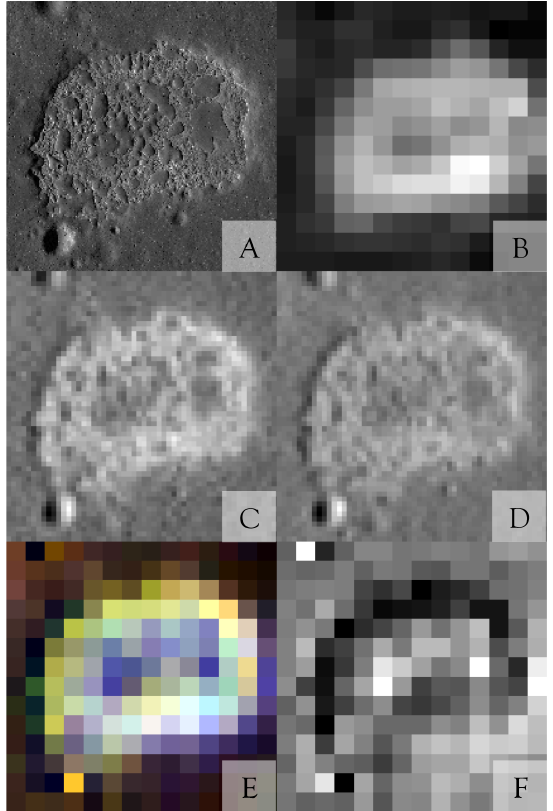
Figure 1: Ina-D - A) Pan - 16 m/px, B) MS UV 1 - 256 m/px, C) MS Vis 1 - 64 m/px, D) MS Vis 5 - 64 m/px, E) MS composite image (red: Vis 5, green: Vis 1, blue: UV 1) - 256 m/px F) MS ratio image: UV 1 / Vis 1 - 256